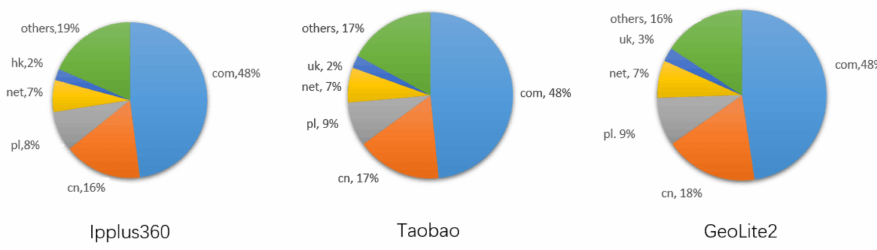
Figure 10. Top 5 TLD of USA overseas server dependency domain